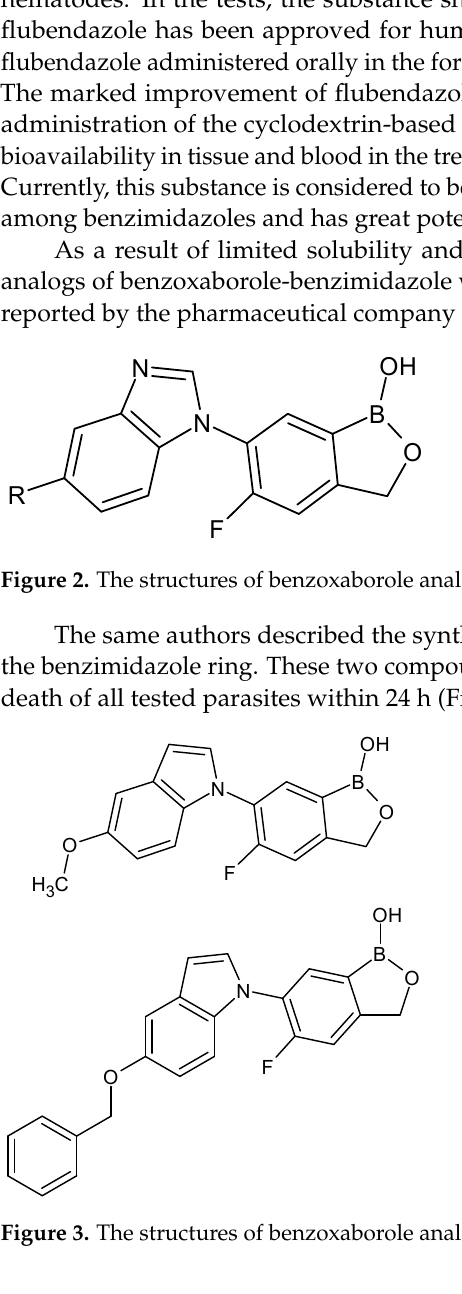
8a Figure 4. The structures of benzimidazole derivatives . 3.5. Oxfendazole Oxfendazole is a benzimidazole derivative with a broad spectrum of antiparasitic activity. It is a drug approved for use in veterinary medicine. The announcement is a new use of this drug in the treatment of onchocerciasis. In preclinical studies, oxfendazole has shown significant antiparasitic activity in the treatment of neurocysticercosis and intesti- nal parasites. Oxfendazole exhibits lipophilic properties. It is characterized by low solu- bility in water. Its bioavailability can be increased through the consumption of high-fat foods. It has been shown in studies that an increase in the dose of oxfendazole leads to a decrease in its bioavailability. The drug was well tolerated by the participants in the study, regardless of their gender. No significant side effects were recorded after the administra- tion of the drug. Based on the research, it was found that oxfendazole shows macrofilaricidal effec- tiveness both after oral and subcutaneous administration. Compared to flubendazole, it has better pharmacokinetic properties. Oxfendazole shows a much better bioavailability than flubendazole after oral administration [44].